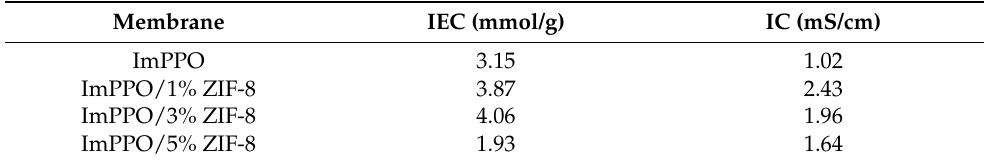
Table 2. Properties of the ImPPO/ZIF 8 composite membranes.